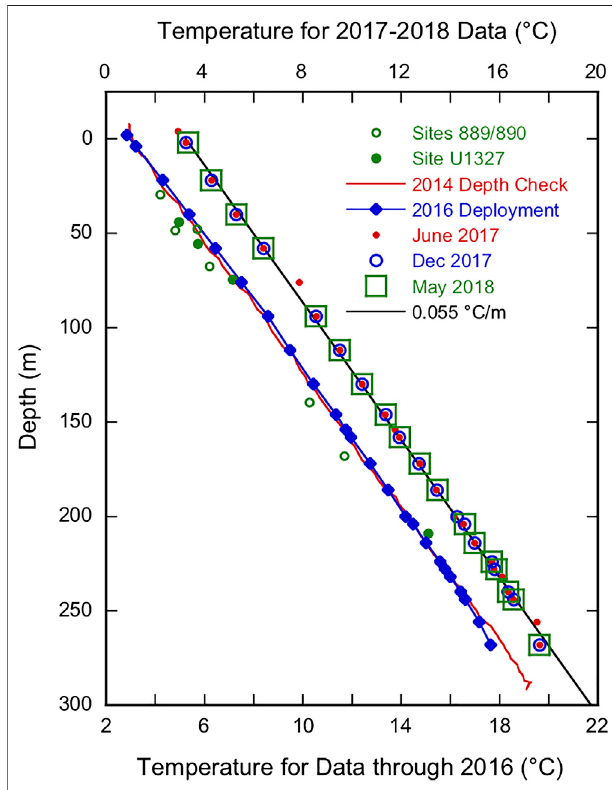
FIGURE 5 | Comparison of temperature-depth pro fi les in Hole U1364A obtained with: the 2014 downgoing CTD depth check, the 2016 initial deployment of the thermistor cable, and representative thermistor cable readingsloggedbyONC inJune2017,December2017,andMay 2018. Note that thetemperaturescale forthe 2014and 2016data isshifted by − 2 ° C for visual clarity. For reference, also shown are earlier downhole temperature probe readings obtained in Sites 889 and 890 in 1992 (Shipboard Scienti fi c Party, 1994) and Site U1327 in 2011 (Expedition 311 Scientists, 2006b).